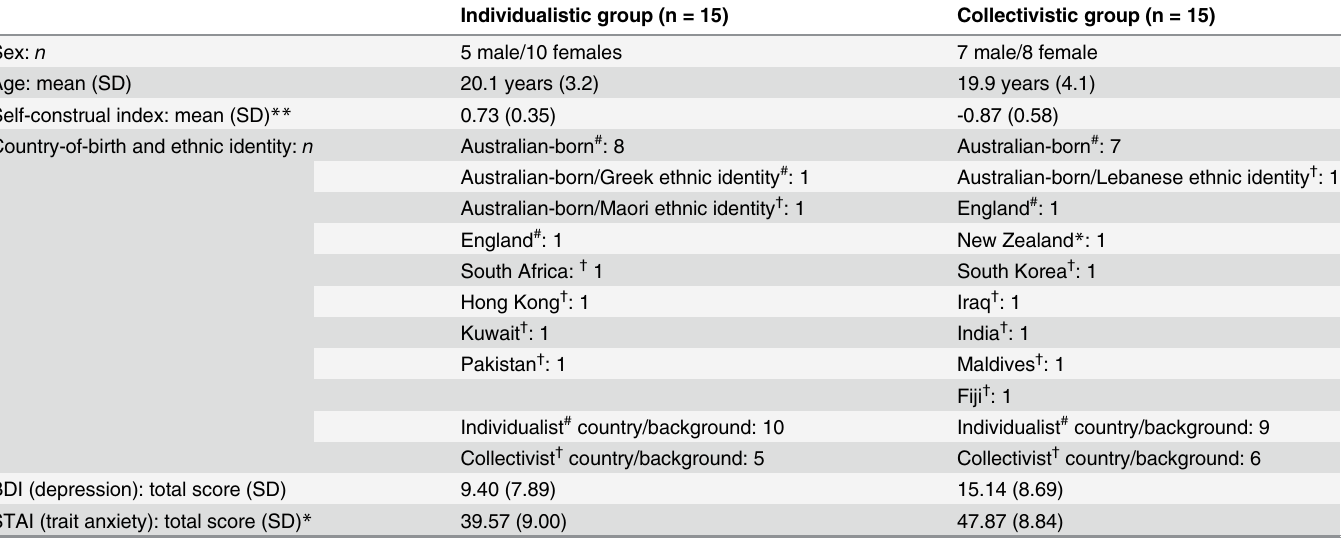
Table 2. Demographics and self-report data for Individualistic and Collectivistic